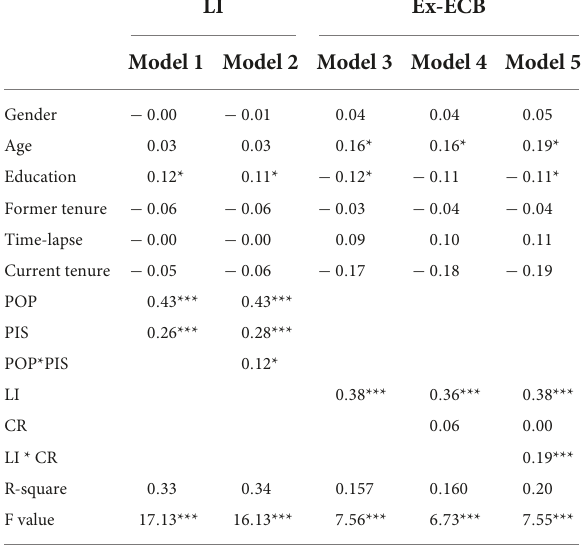
TABLE 4 Results of multiple regression